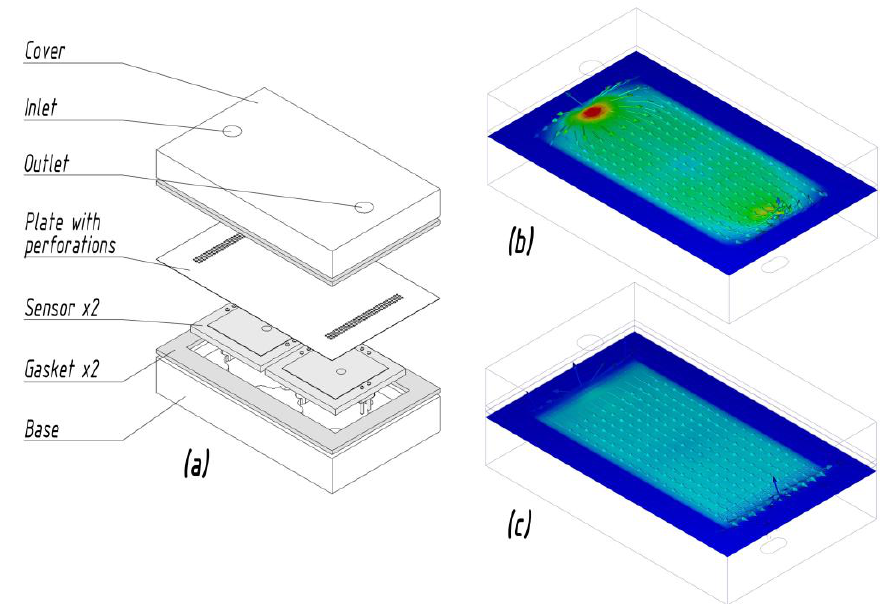
Figure 3. ( a ) Exploded view drawing of the sensor module; ( b ) flow velocity magnitude along the sensors’ surface without the perforated plate and ( c ) with the perforated plate.